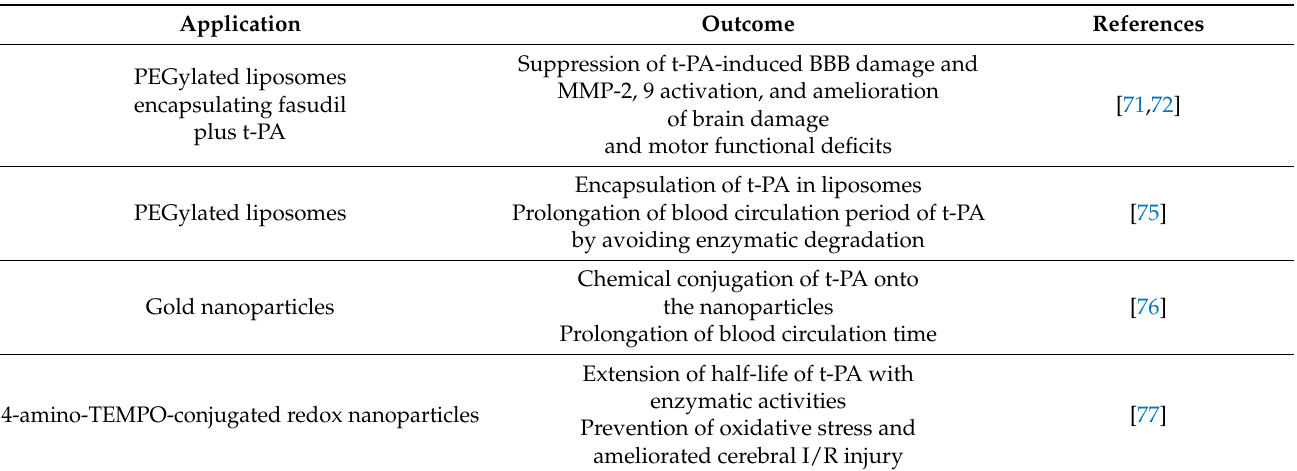
Figure 2. Combination therapy with the thrombolytic agent t-PA and neuroprotective nanoparticles. Table 3. List of combination therapies and nanoparticle applications for t-PA delivery, as described in Section 3.